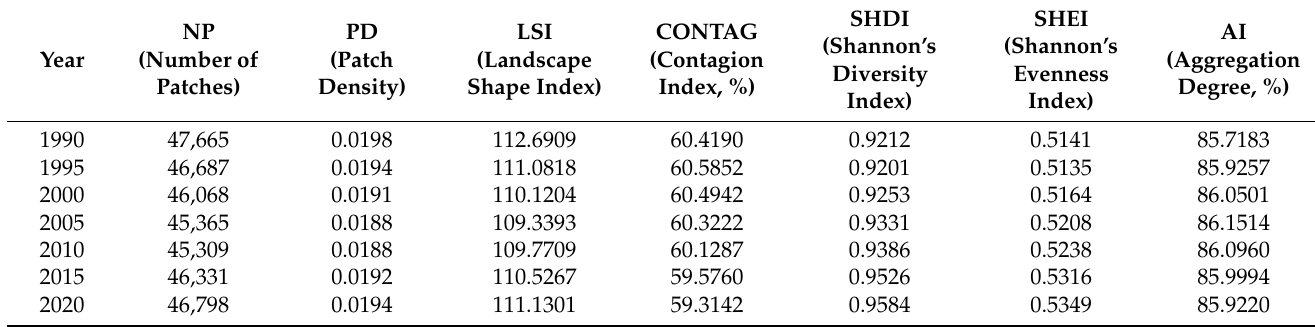
Table 1. Change of landscape pattern index in the study area at landscape level.